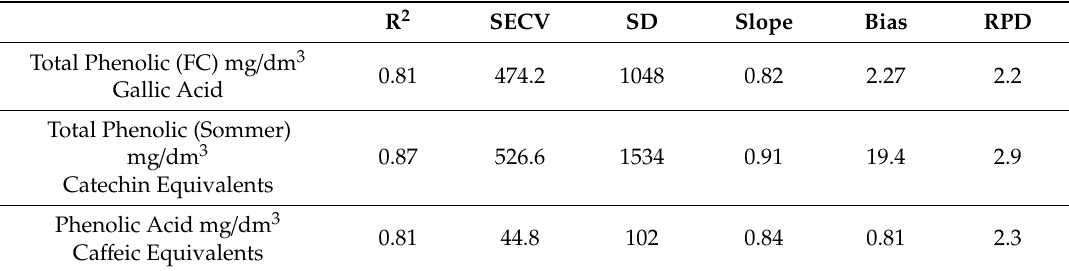
Table 2. Calibration statistics for the prediction of total phenolics in the set of wine samples analyzed using Raman